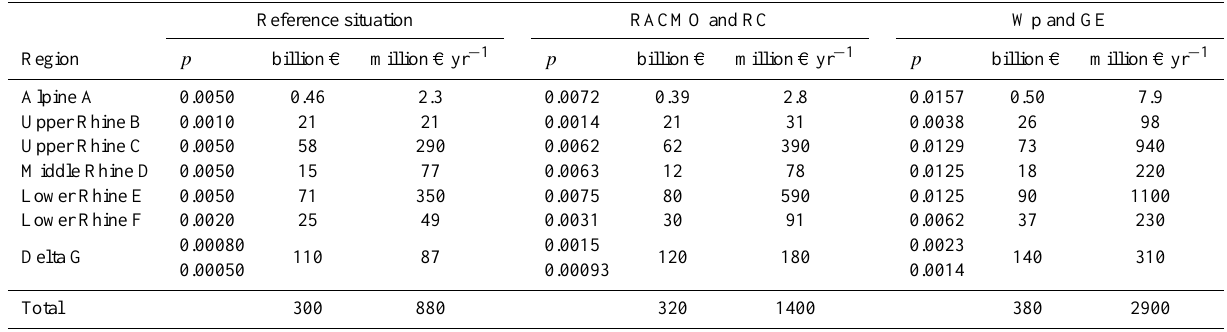
Table 7. Annual expected damage (risk) in million C per year for different regions in 2000 and 2030 (at 2000prices). Reference situation RACMO and RC Wp and GE